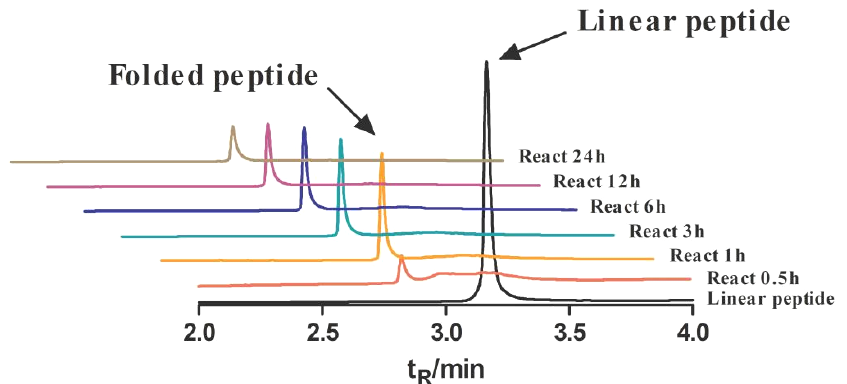
Figure 3. HPLC graphs of folding products of Lv32.1 in 0.1 M NH 4 HCO 3 buffer with 1 mM GSH/0.5